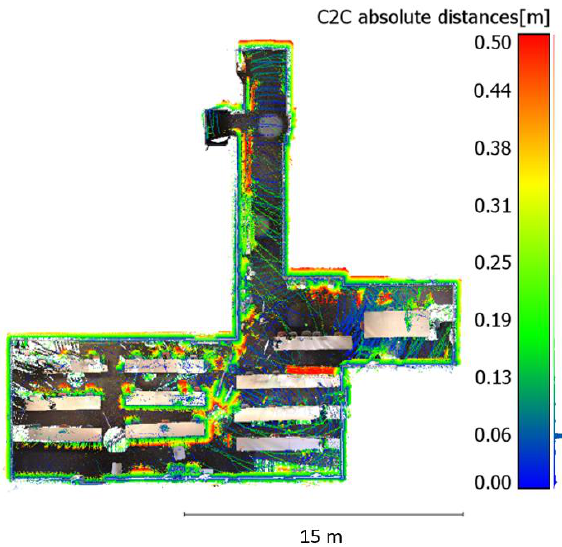
Figure 10 . Top view of the TLS point cloud map (the ceiling points are not shown in order to show the interior structure) and Grape point cloud (coloured based on point distance to the TLS map) for the FOI dataset.